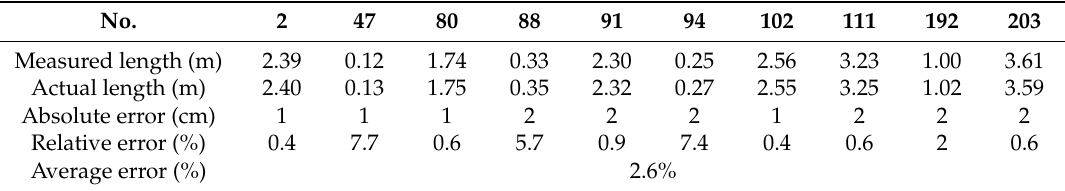
Table 3. Comparison of measured and actual lengths.